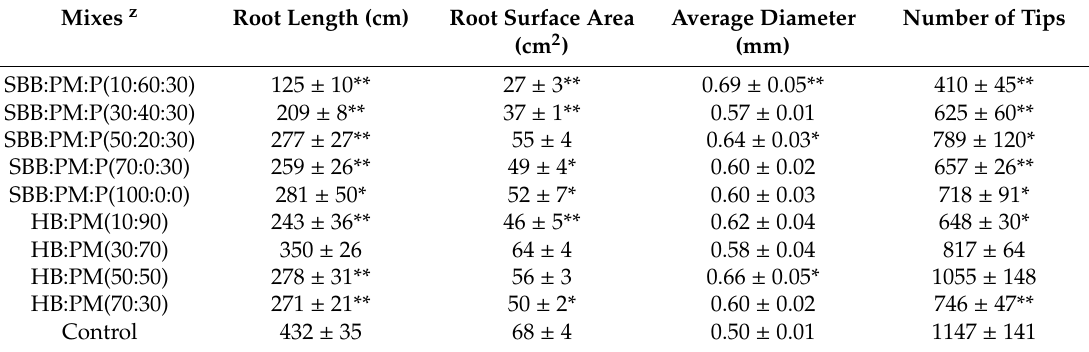
Table 2. Root growth of tomato seedlings grown in di ff erent mixes (*, ** indicate a significant di ff erence from the control using Dunnett’s test at p ≤ 0.05 and p ≤ 0.01,